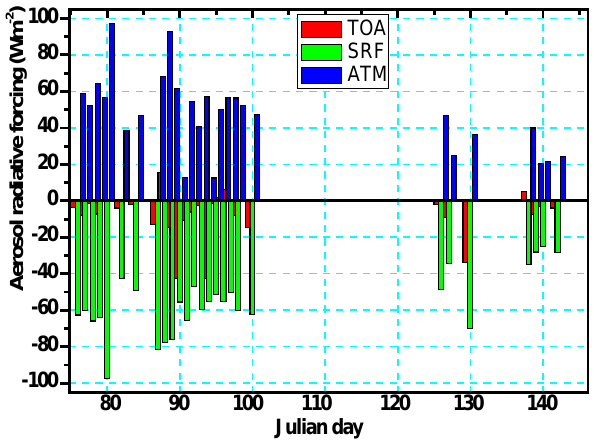
Fig. 8. Daily mean ARF at the surface (green), top of the atmosphere (red) and in the atmosphere (blue) in MAM 2009 at SACOL. 5 where F N and F N are daily mean net solar radiative TOA TOA , Ray flux at the TOA with and without aerosols, respectively. Fig- ure 8 shows the daily mean radiative forcing at the surface (green), TOA (red) and in the atmosphere (blue) in MAM 2009. Aerosols at SACOL have a strong negative radiative forc- ing at the surface, ranging from − 24.85 to − 97.41 W m − 2 . The negative forcing is the largest ( − 97.41 W m − 2 ) on 21 March 2009, which corresponds with the largest value of AOD in MAM 2009. The surface ARF at other site over loess plateau of Northwest China (Ge et al., 2010) ranges from − 7.9 to − 35.8 W m − 2 from 25 April to 25 May, while the averaged ARF at the surface in our study ranges from − 24.85 to − 70.26 W m − 2 from April to May. The critical reason of such difference is the larger optical depth in our study. Daily averaged values of radiative forcing at the surface in May